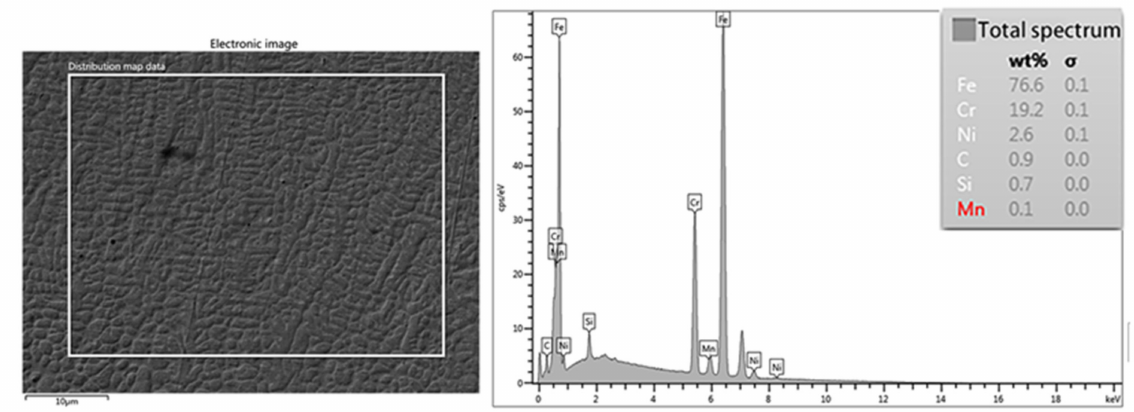
Figure 4. EDS analysis diagram of the microstructure in the middle area of the cross-section of the Figure 5. EDS analysis diagram at the interface of Fe-based alloy laser cladding layer.